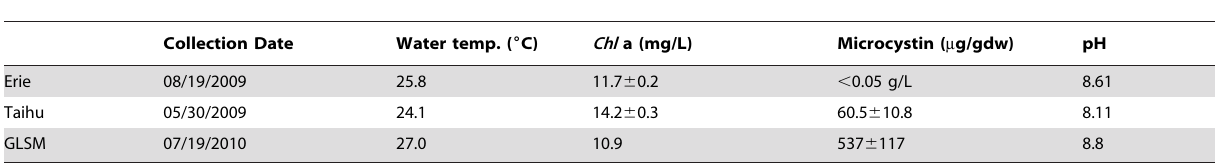
Table 1. Bloom sample